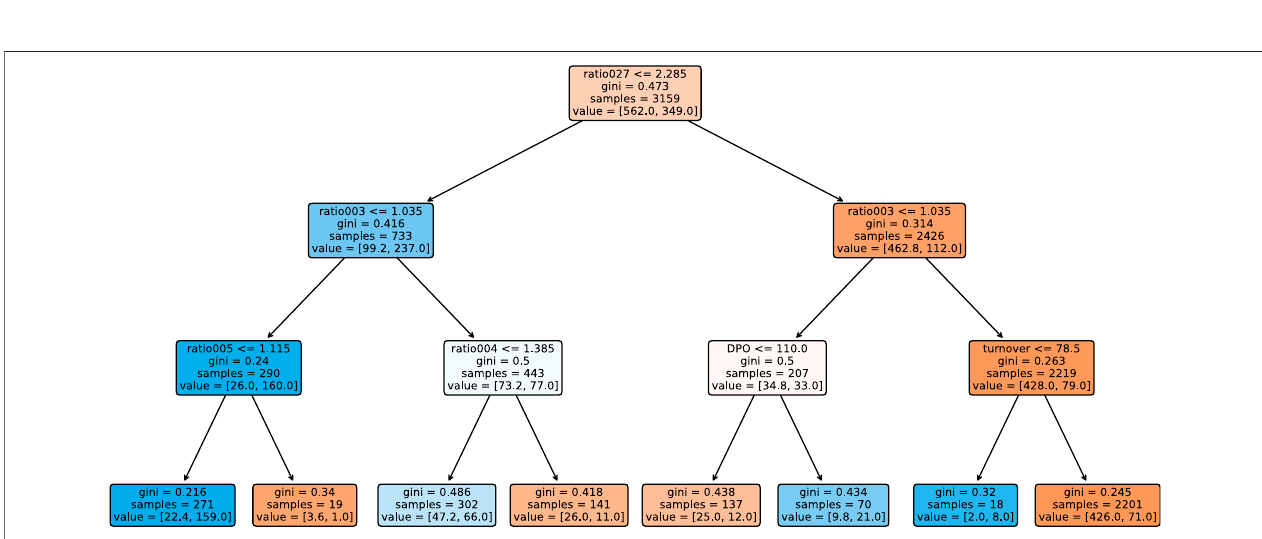
FIGURE9| Treegrownusingthedataset,wheretheweightofthenon-defaultingcontractsisreducedbyafactorof0.2relativetothedefaultingcontracts.Thistree maximizes the banks pro fi t.